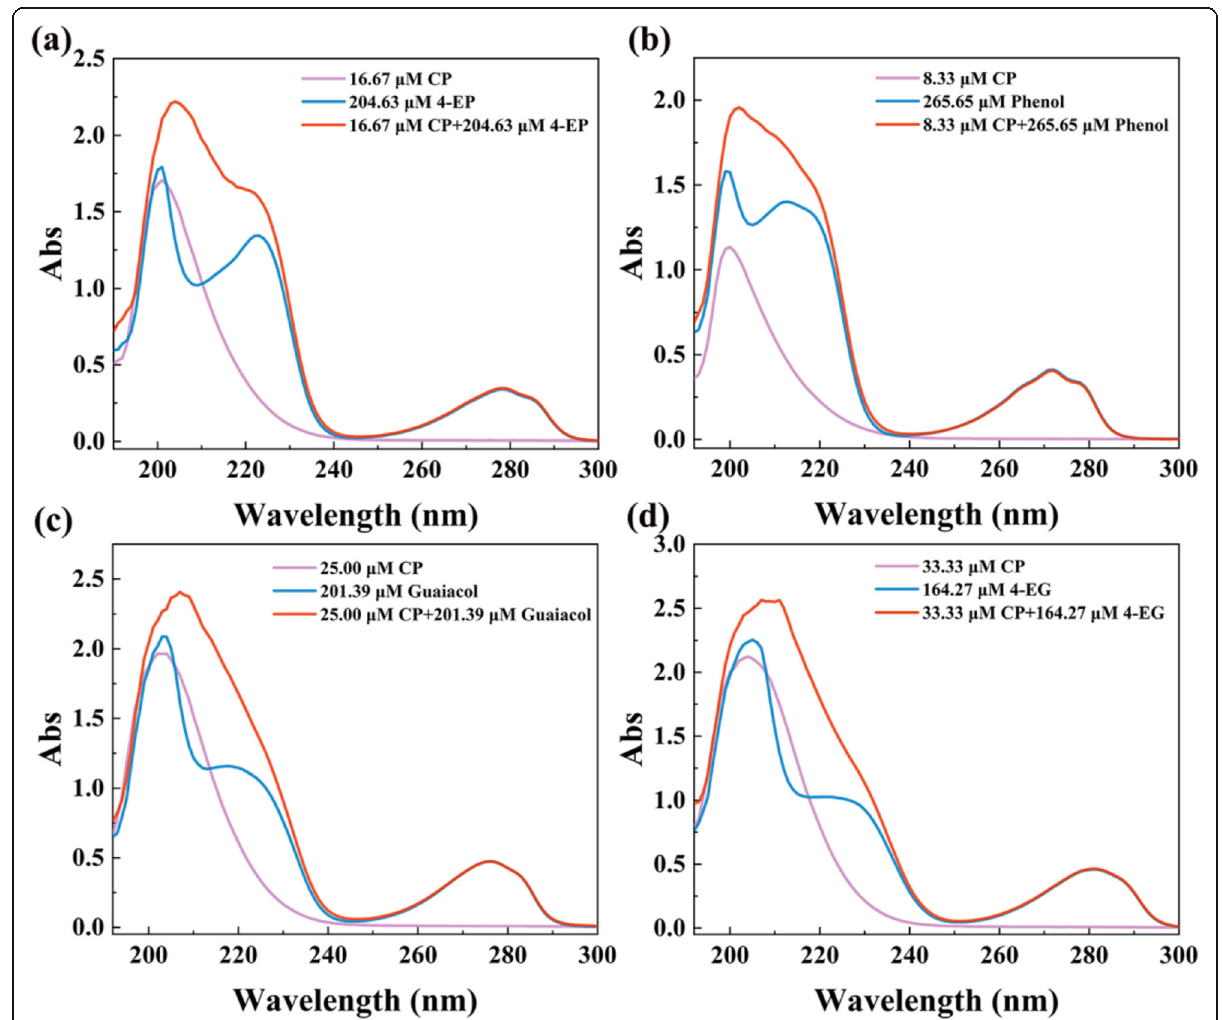
Fig. 1 UV-Vis spectrum of Collagen peptides with 4-EP ( a ), phenol ( b ), guaiacol ( c ), and 4-EG ( d